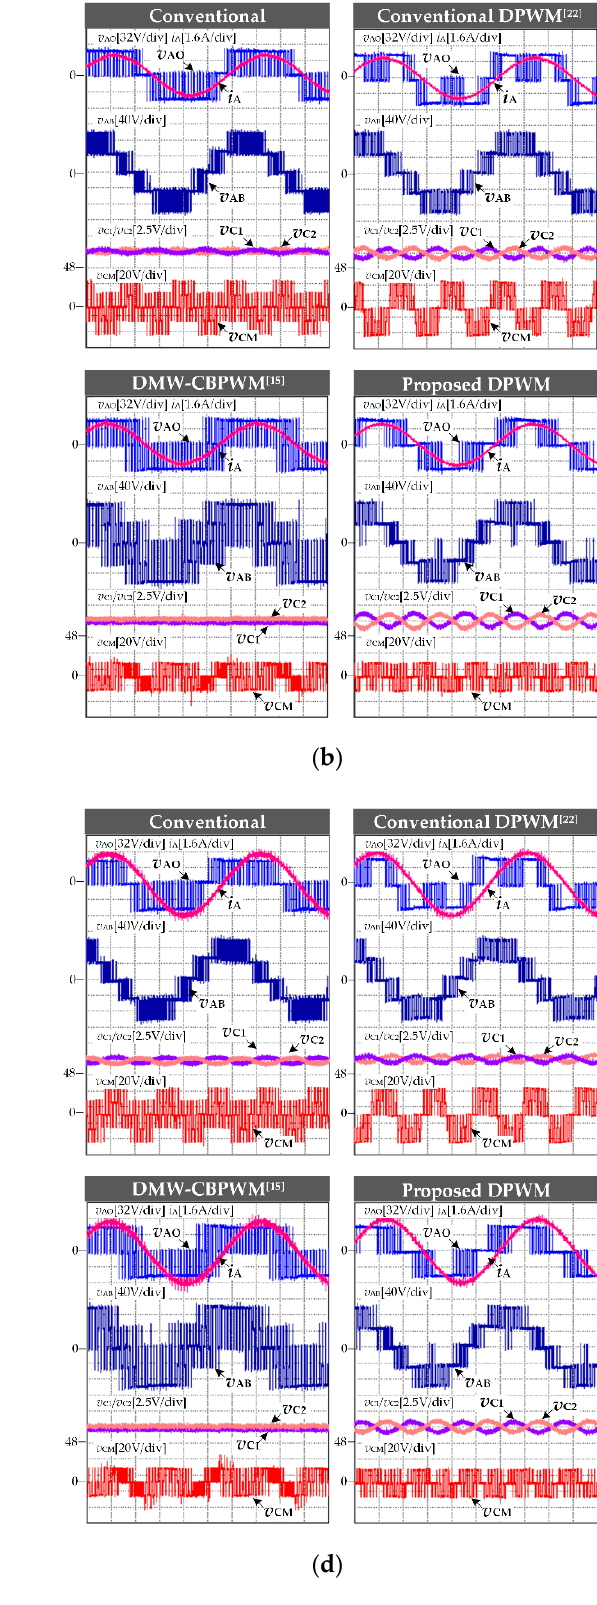
Figure 12. Experimental results of phase voltage v AO , current i A , line voltage v AB , upper and lower-capacitor voltages v C1 / v C2 and common voltage v CM . ( a ) m = 0.3, cos θ = 0.954; ( b ) m = 0.8, cos θ = 0.954; ( c ) m = 0.3, cos θ = 0.732; ( d ) m = 0.3, cos θ = 0.732.